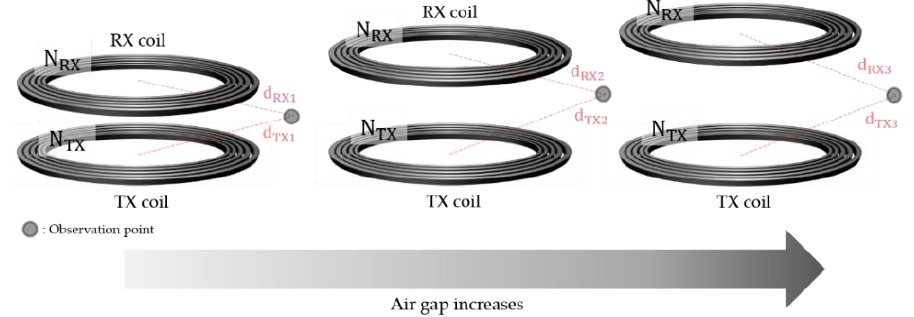
Figure 9. Variations in the air gap between the TX coil and RX coil.